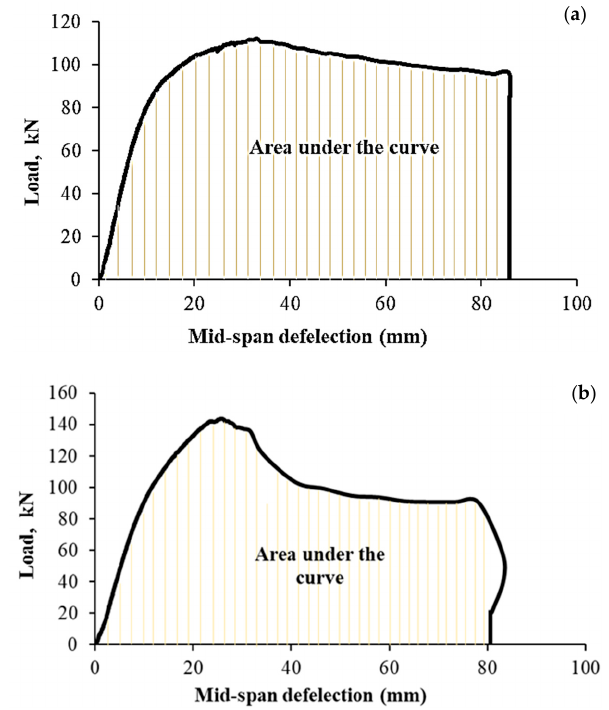
Figure 10. Characteristic load versus midspan deflection curves for assessing the energy absorption, ( a ) control specimen (B-C) and ( b ) strengthened specimen (B-P100-2L).